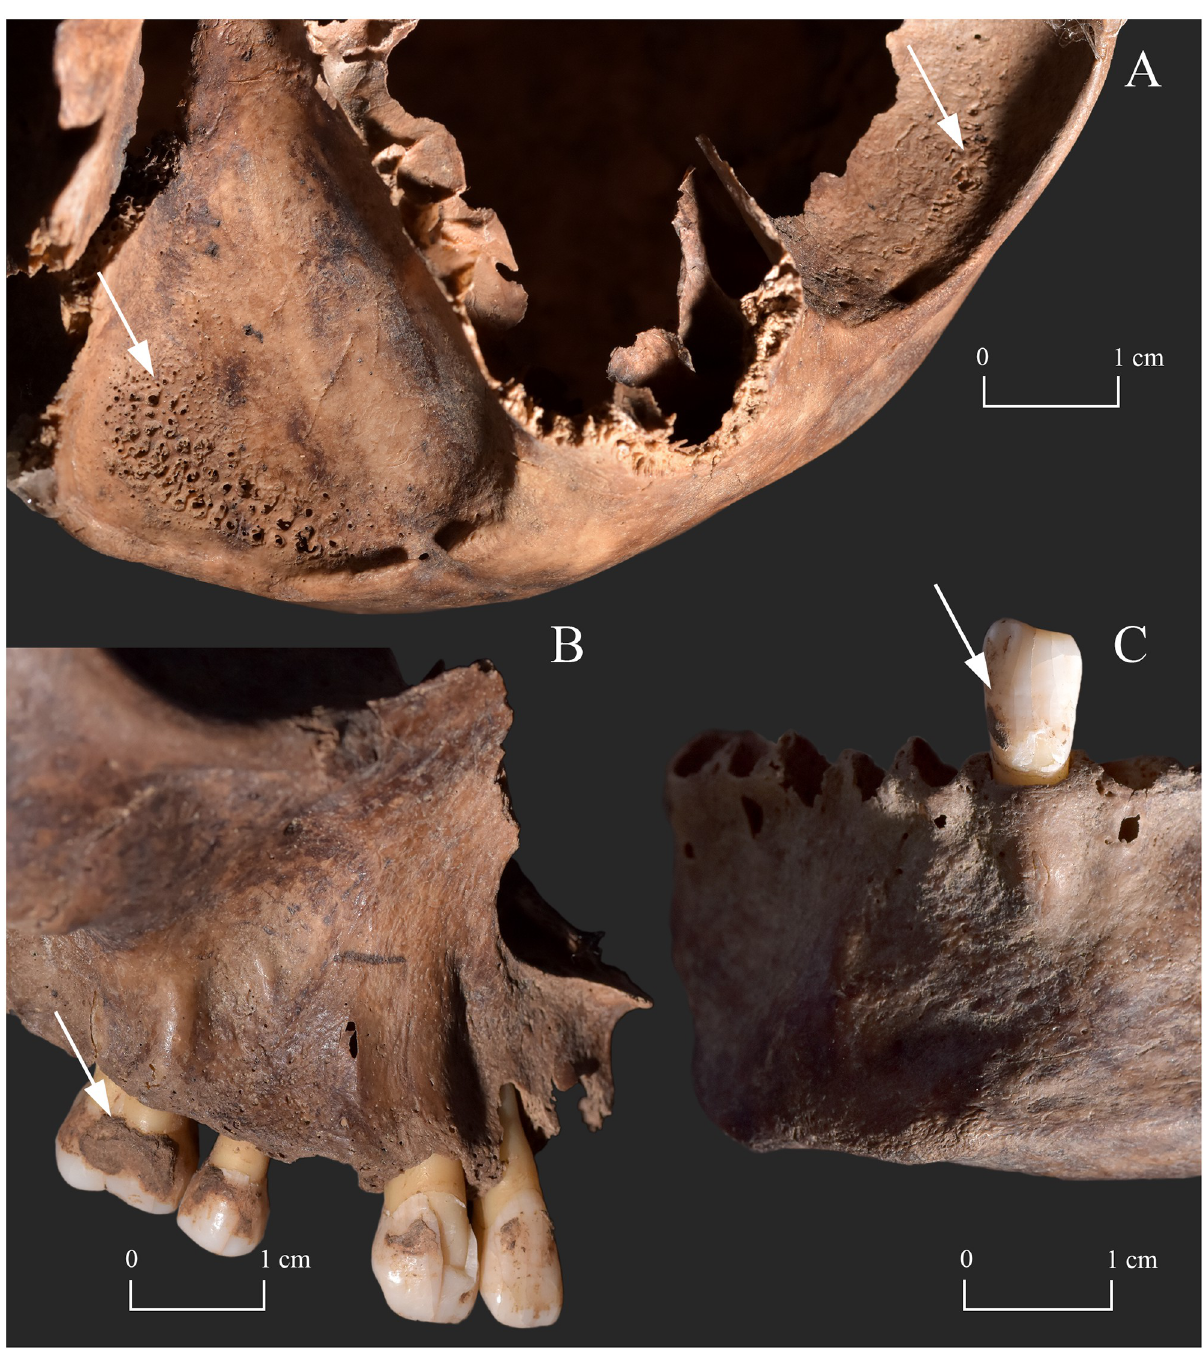
Fig 9. A) Porotic cirbra orbitalia in the left and right orbits of KD520 (white arrows); B) Dental calculus on the maxillary teeth of KD520 (white arrow); and C) Dental calculus and linear enamel hypoplasia (white arrow) on the left lower canine of